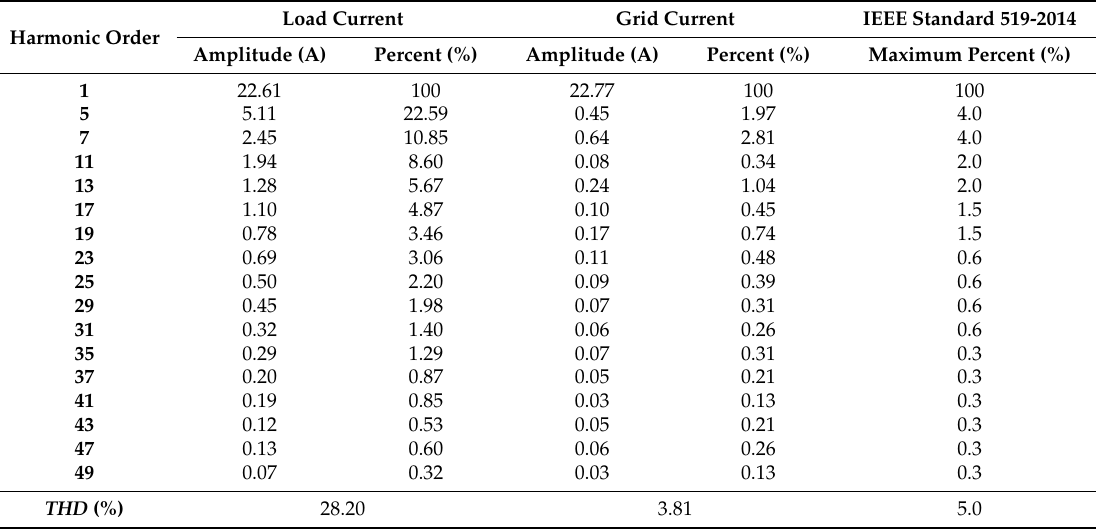
Figure 12. The FFT analysis of phase A grid current in steady-state condition. Table 2. Detailed simulation data. Table 2. Detailed simulation data.